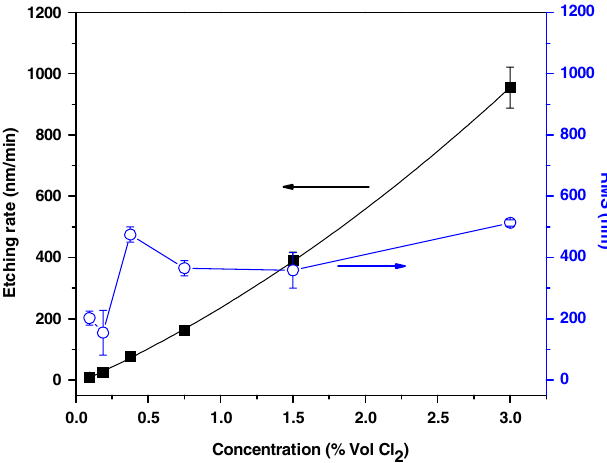
FIG. 1. Etching rate and surface RMS dependence on Cl 2 concentration. Experimental conditions: total gas flow 196 sccm, pressure in reaction chamber 340 mTorr, and input power density 1 : 40 W = cm 3